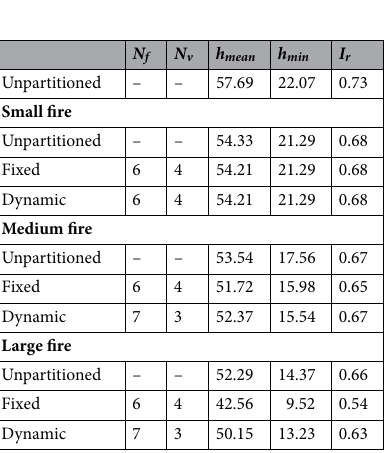
Figure 8. Weights of C-Town’s pipes.